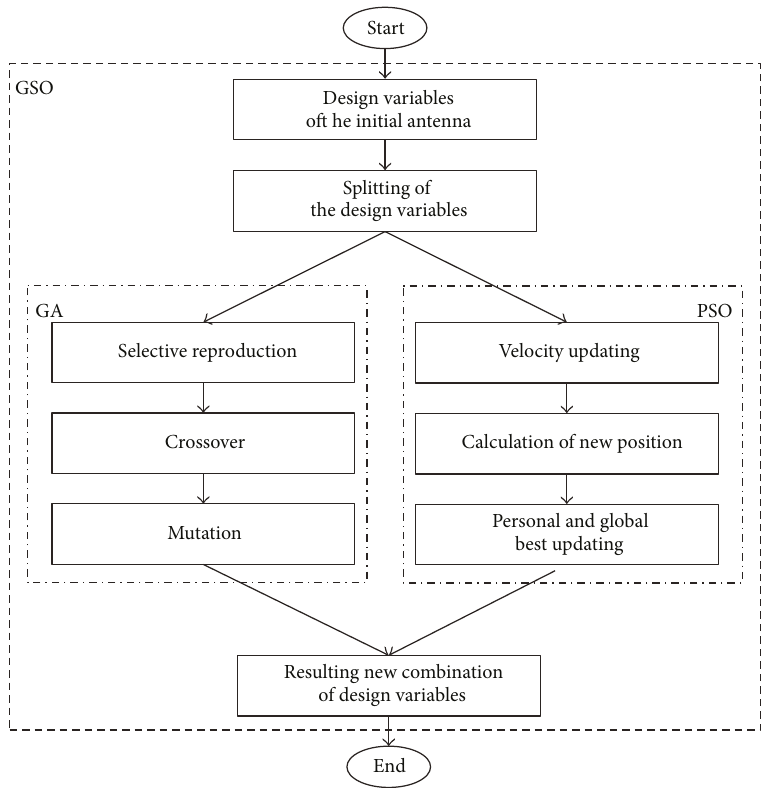
Figure 3: Flowchart of the updating rule of